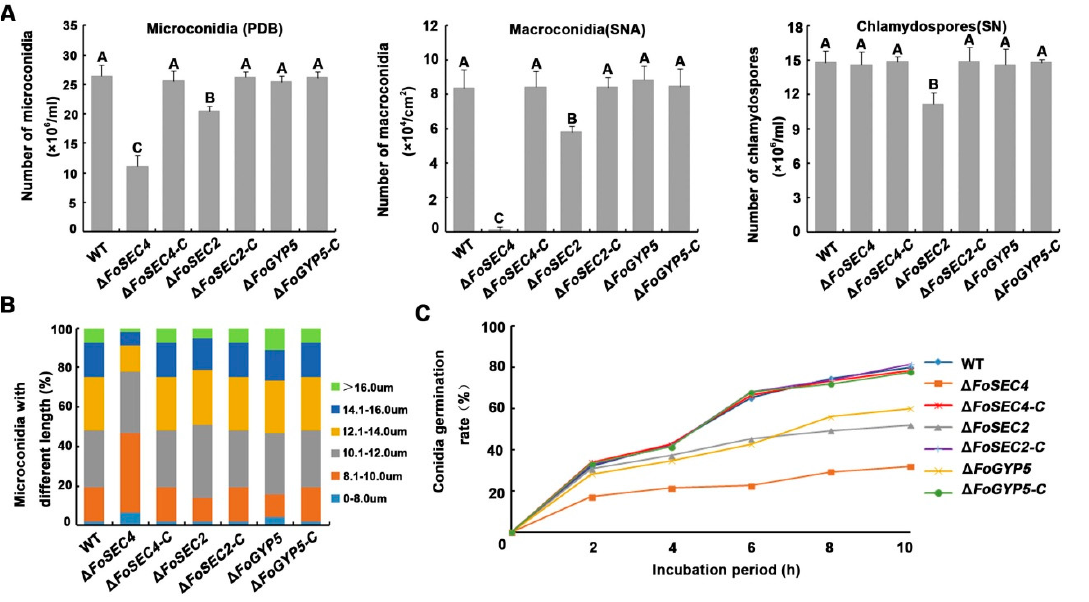
Figure 4. FoSec2 and FoSec4 participate in the regulation of the reproduction process of F. odoratissimum. ( A ) Microconidia were measured by counting the number in PDB culture after 3 days. Macroconidia were measured by counting the number in SNA plate culture after 14 days. Chlamydospores were measured by counting the number in SN after 14 days. The error bars represent the standard deviation (SD) of three replicates, and the values on the bars followed by the same letter are not significantly different at p = 0.01. ( B ) The length of microconidia in all the above strains. ( C ) The germination rates of microconidia of each strain after incubation for 2 h, 4 h, 6 h, 8 h and 10 h.